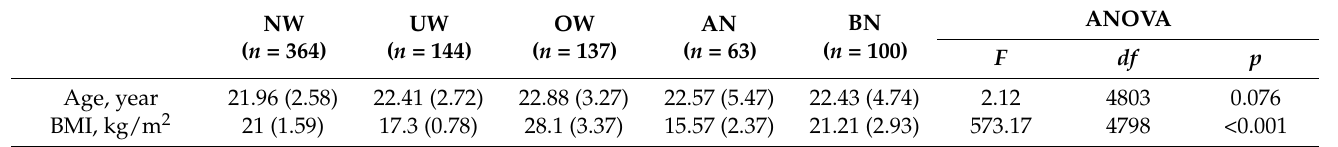
Table 1. Age and BMI of young women with NW, UW or OW, and patients with AN and